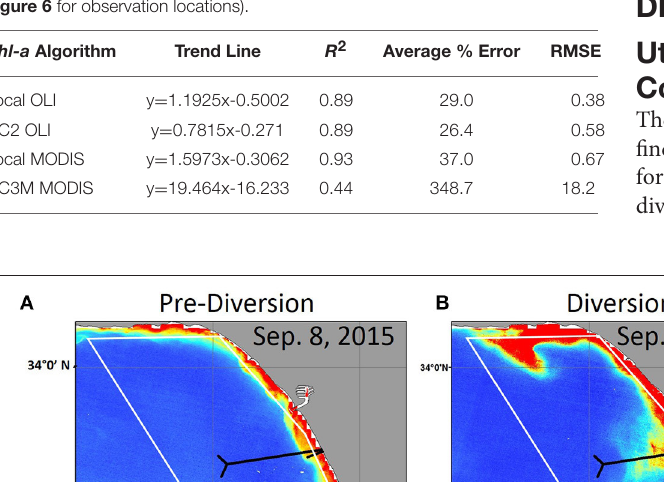
Frontiers in Marine Science |